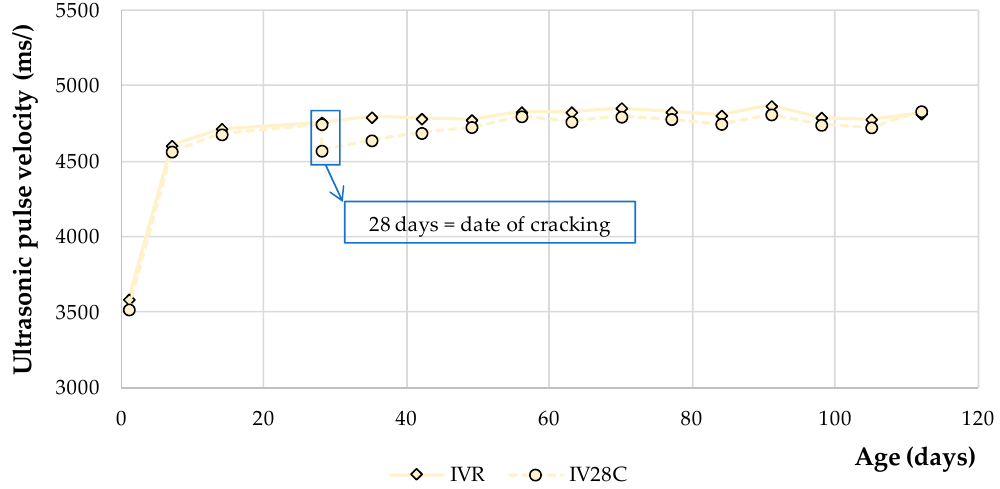
Figure 3. Ultrasonic pulse velocity of uncracked concrete (IVR) and 28 day cracked concrete (IV28C) with CEM IV/A.